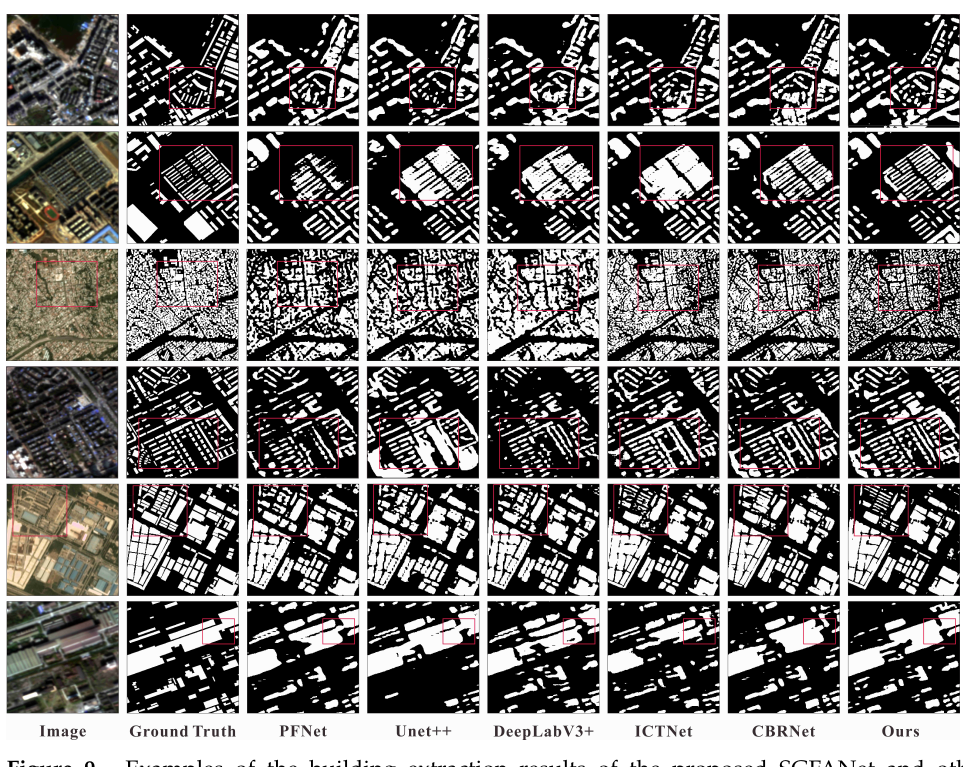
Figure 9. Examples of the building extraction results of the proposed SGFANet and other SOTA methods. The red squares indicate our notable improvement.